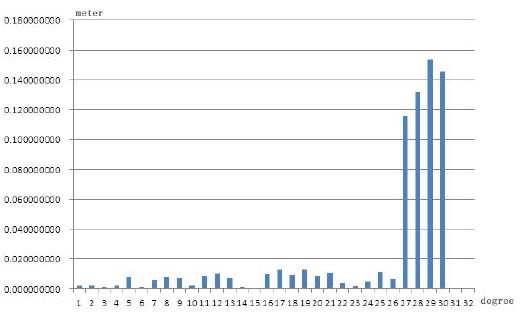
Figure 5. The spot center location error for different